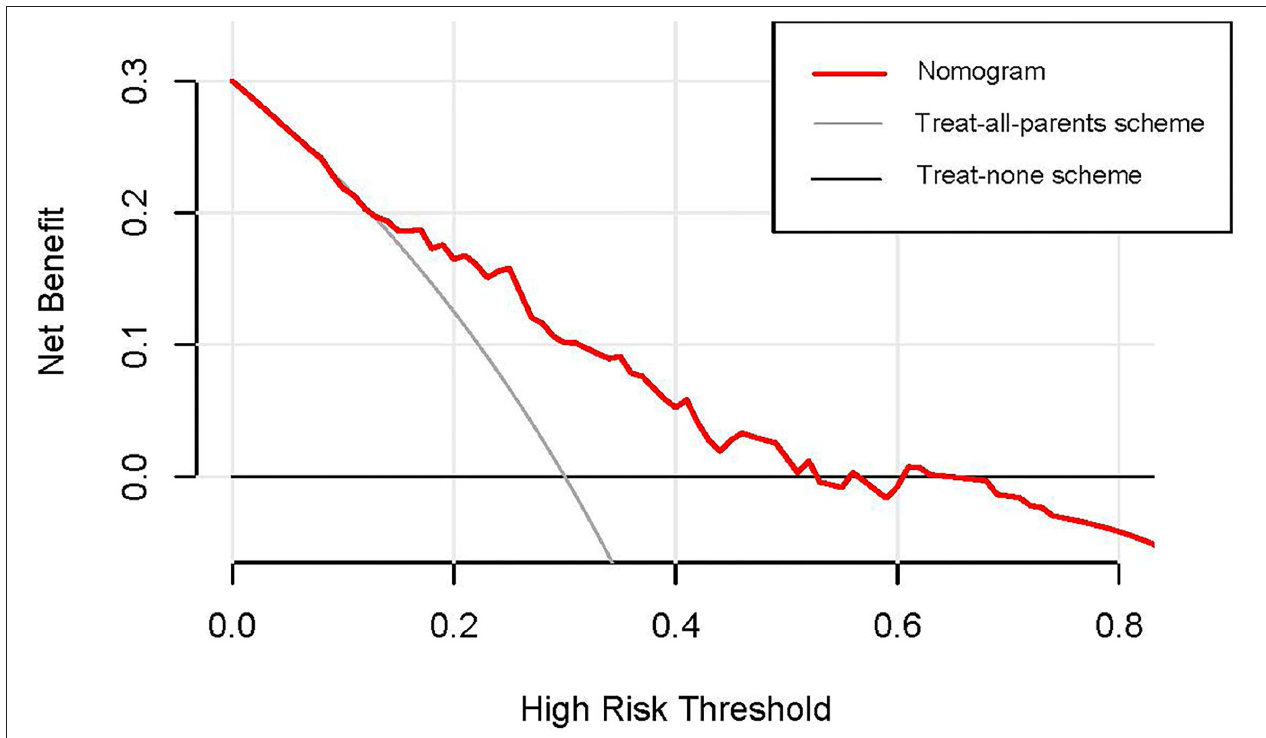
FIGURE 6 | The decision curve analysis of the nomogram in the entire dataset. The y-axis measures the net benefit, and the x-axis measures the probability threshold. The red line represents the nomogram. The black line (treat-none scheme line) represents the assumption that all parents are unresolved statuses. The gray line (treat-all-parents scheme line) represents the assumption that no parent is unresolved status. The decision curve analysis (DCA) indicated that the nomogram provided more benefits than the treat-all-parents scheme and treat-none scheme when the threshold probability of unresolved status was > 13% and <